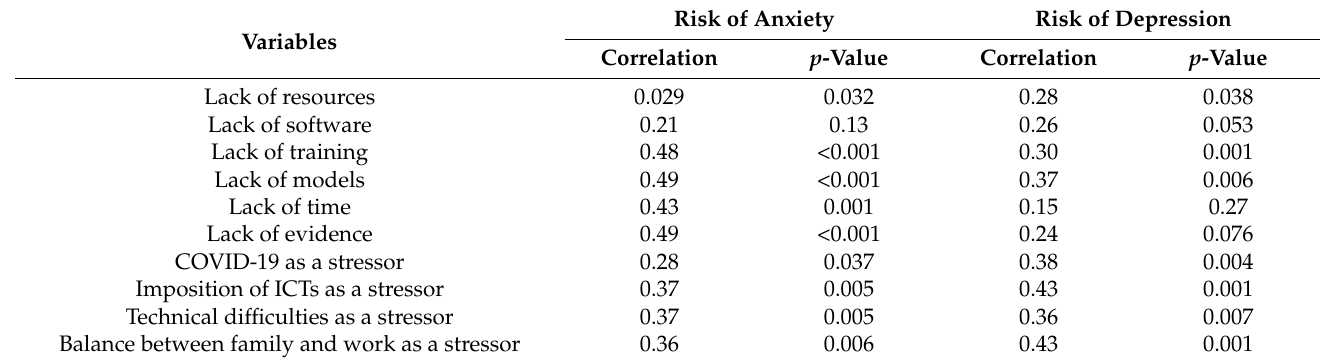
Table 5. Variables that indicated significant differences for the anxiety and depression